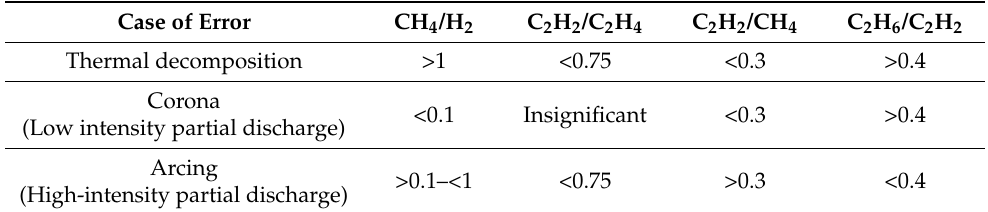
Table 2. Fault analysis based on Doernenburg